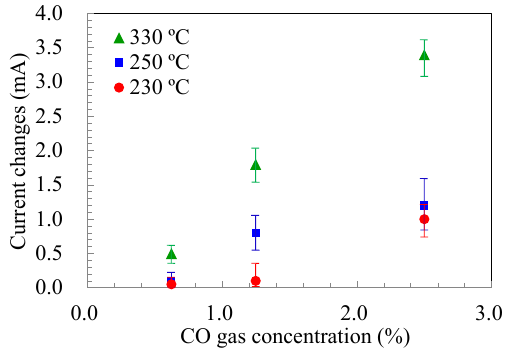
Figure 5. Dependence of current change in ZnO films on CO gas concentration. The carrier concentration was 1.8×10 20 cm -3 . The sample temperatures were 230, 250 and 330ºC.